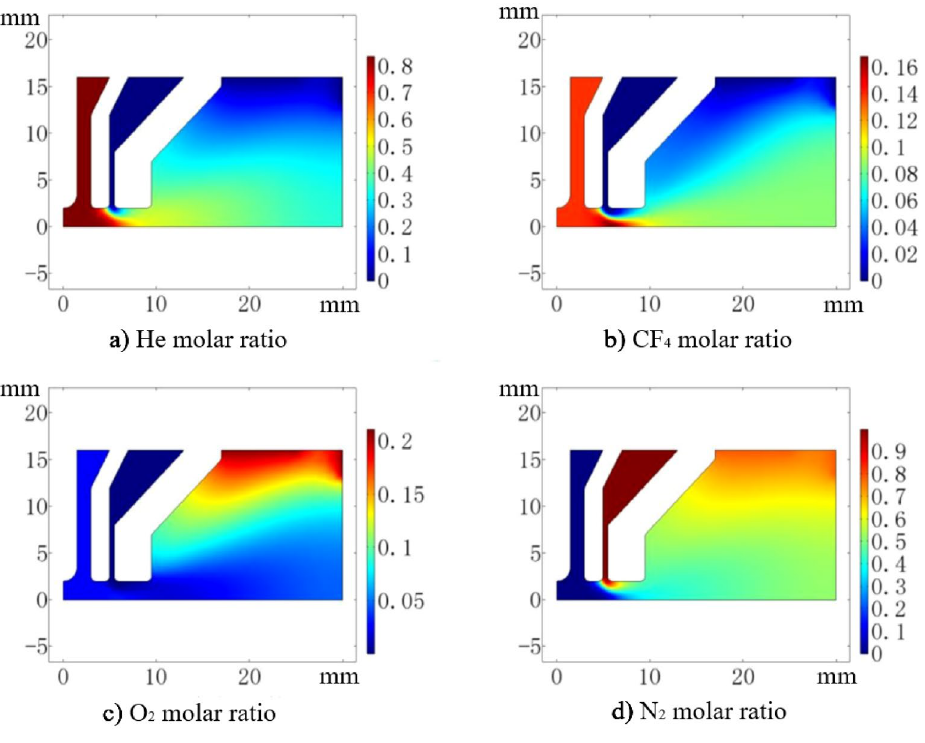
Figure 5. Molar ratio spatial distributions of He, CF 4 , O 2 and N 2 .